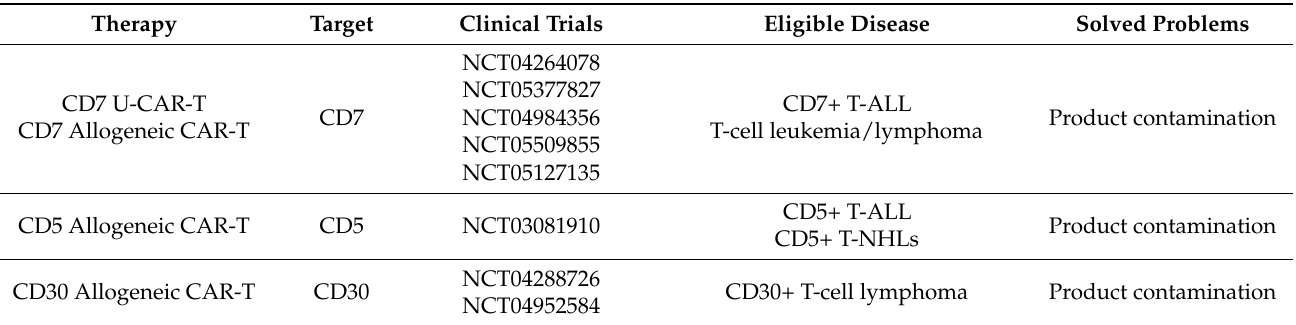
Table 2. Clinical trials for solving product